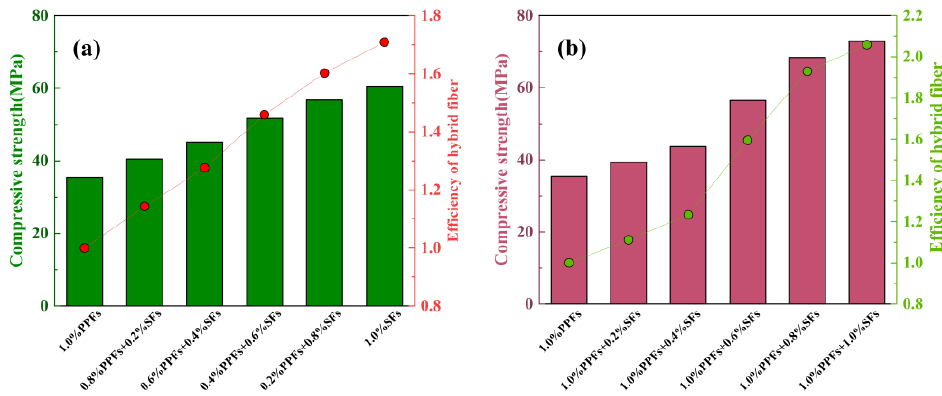
Figure 15. The effect of fiber hybrid effect on compressive strength: ( a ) The replacement type; ( b ) the addition type.